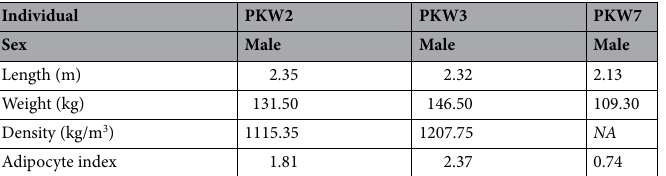
Table 3. Summary of post-mortem examination results of three pygmy killer whales comparing a non-fasting individual (PKW7) that stranded on August 29, 2019 to likely-fasting individuals, PKW2 and PKW3, that stranded on September 23, 2019 after 11 continuous days of observation and retrieval by NOAA Fisheries in the nearshore waters of Ma ʻ alaea Bay, Maui.